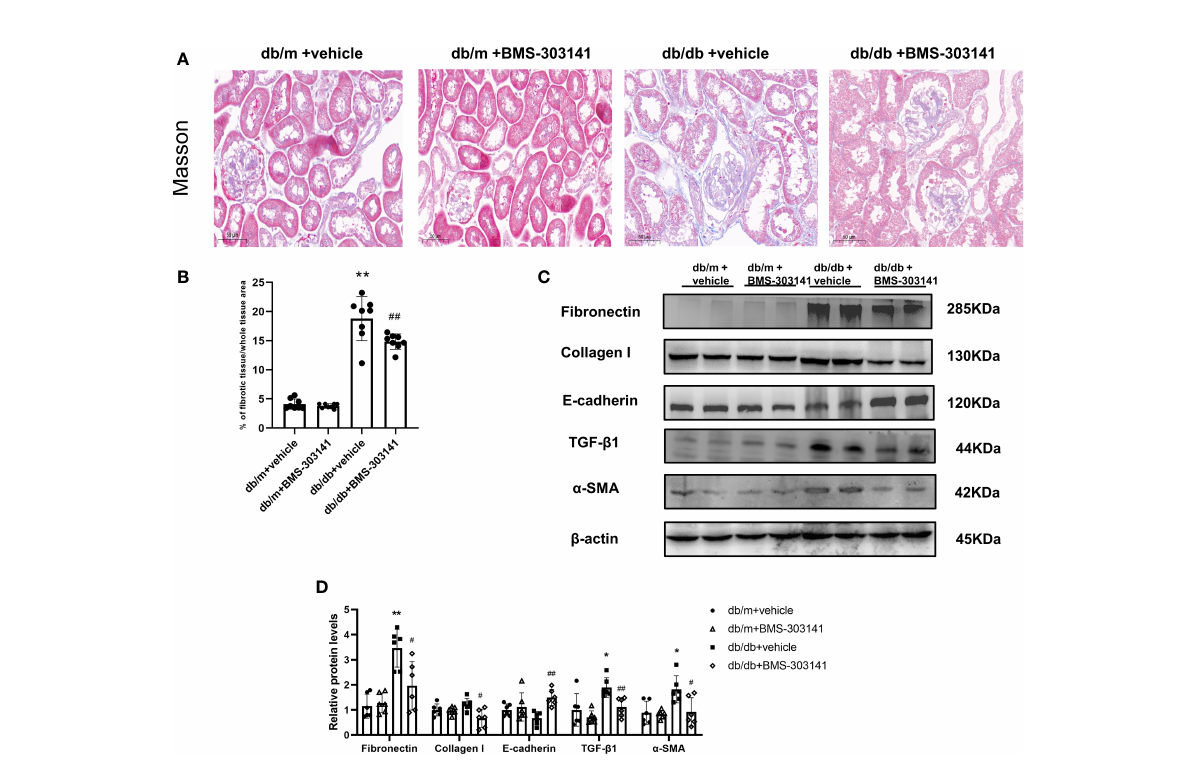
FIGURE 6 In the kidney tissues of db/db mice, BMS-303141 decreases renal interstitial fi brosis. (A) Photomicrographs of renal cortex slices stained with Masson ’ s trichrome per each group; (B) As indicated in the Materials and methods section, the level of tubulointerstitial collagen deposition was measured semiquantitatively. *P < 0.05, **P < 0.01 versus db/m + vehicle group; #P < 0.05, ##P < 0.01 versus db/db + vehicle group, n = 8 per each group; (C, D) Western blots (C) and densitometric quantitation (D) of the indicated protein of renal fi brosis markers, Fibronectin, Collagen I, E-cadherin, TGF- b 1, and a -SMA in the kidney cortex from db/m and db/db mice; *P < 0.05, **P < 0.01 versus db/m + vehicle; #P < 0.05, ##P < 0.01, versus db/db + vehicle group, n = 6 per each group. The mean ± SD of four different tests is represented by each